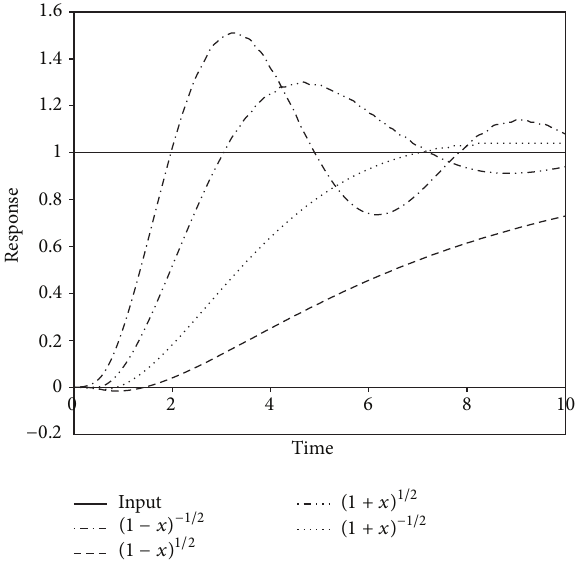
Figure 2: Time response of the unit feedback closed-loop system with transfer function 𝐺(𝑠) = 1/𝑠(𝑠 + 1), 𝐾 = 0.5, 𝑇 = 0.1 s, and the control algorithms